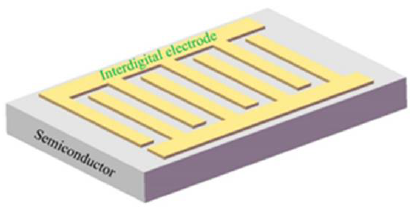
Figure 7. The schematic structure of an inter-digital electrode.